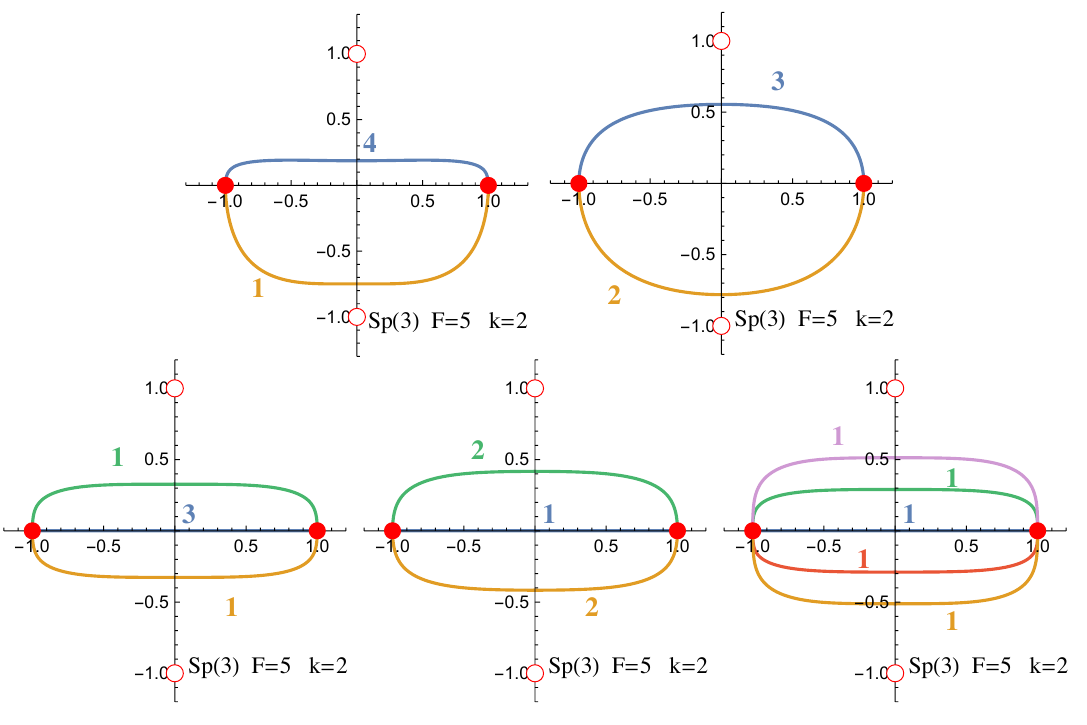
Figure 8 . Examples of domain walls in Sp(3) , F = 5 : the parameters of the defor- mations are, from left to right, top to bottom, (0 , − 1 , − 1 , − 1 , − 1 , − 1) , ( − 1 , − 1 , − 2 , − 2 , − 2) , (0 . 01 , 0 . 01 , − 0 . 1 , − 0 . 1 , − 0 . 1) , (0 . 01 , 0 . 01 , 0 . 01 , 0 . 01 , − 0 . 1) , (0 . 1 , 0 . 1 , 0 , 0 . 2 , 0 . 2)